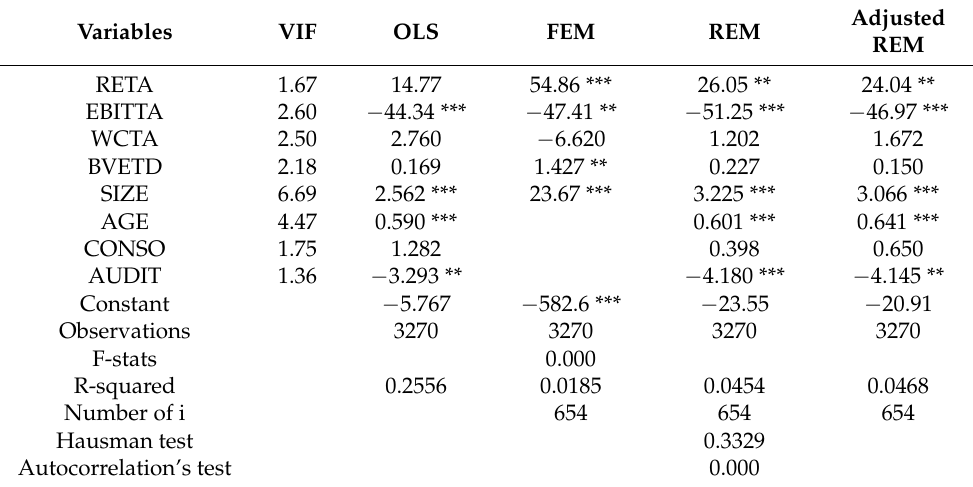
Table 6. Regression results of retained earnings, earnings before interest and tax, liquidity, capital structure, and control variables including firm size, firm age, consolidated reports, and auditing firm type to time of annual reports publication (research model